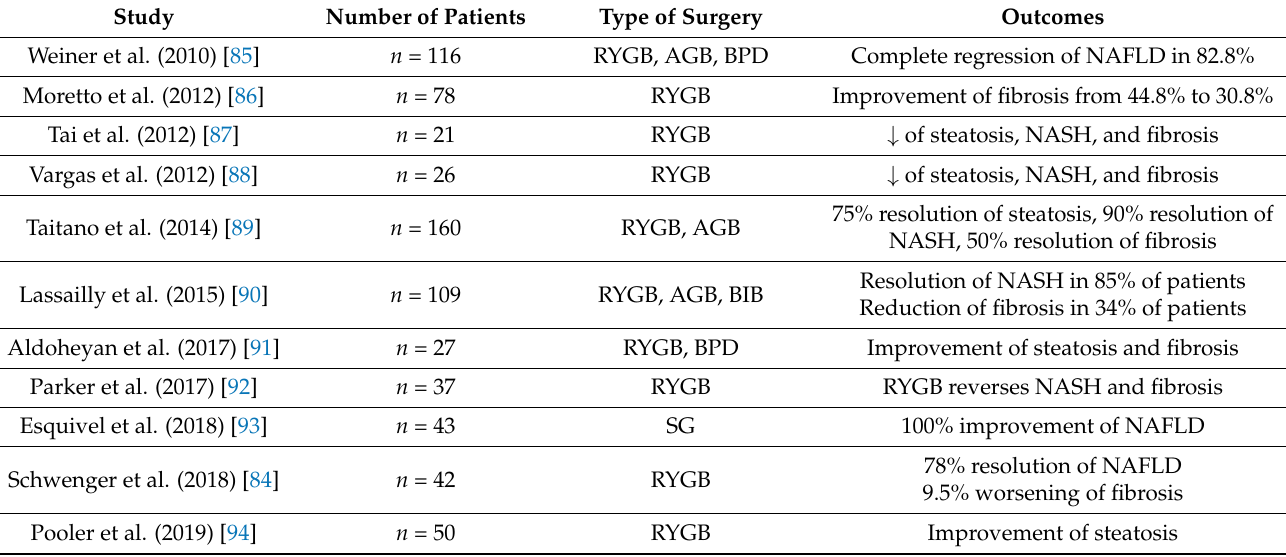
Table 3. The effectiveness of bariatric surgery management in alleviating